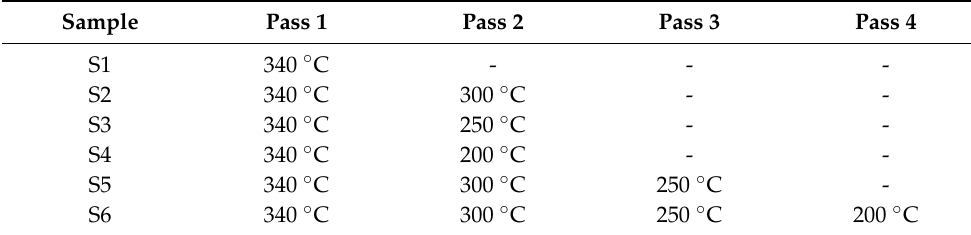
Table 2. Different processing route for SPD of AZ91 alloy by TPCAE method. Sample Pass